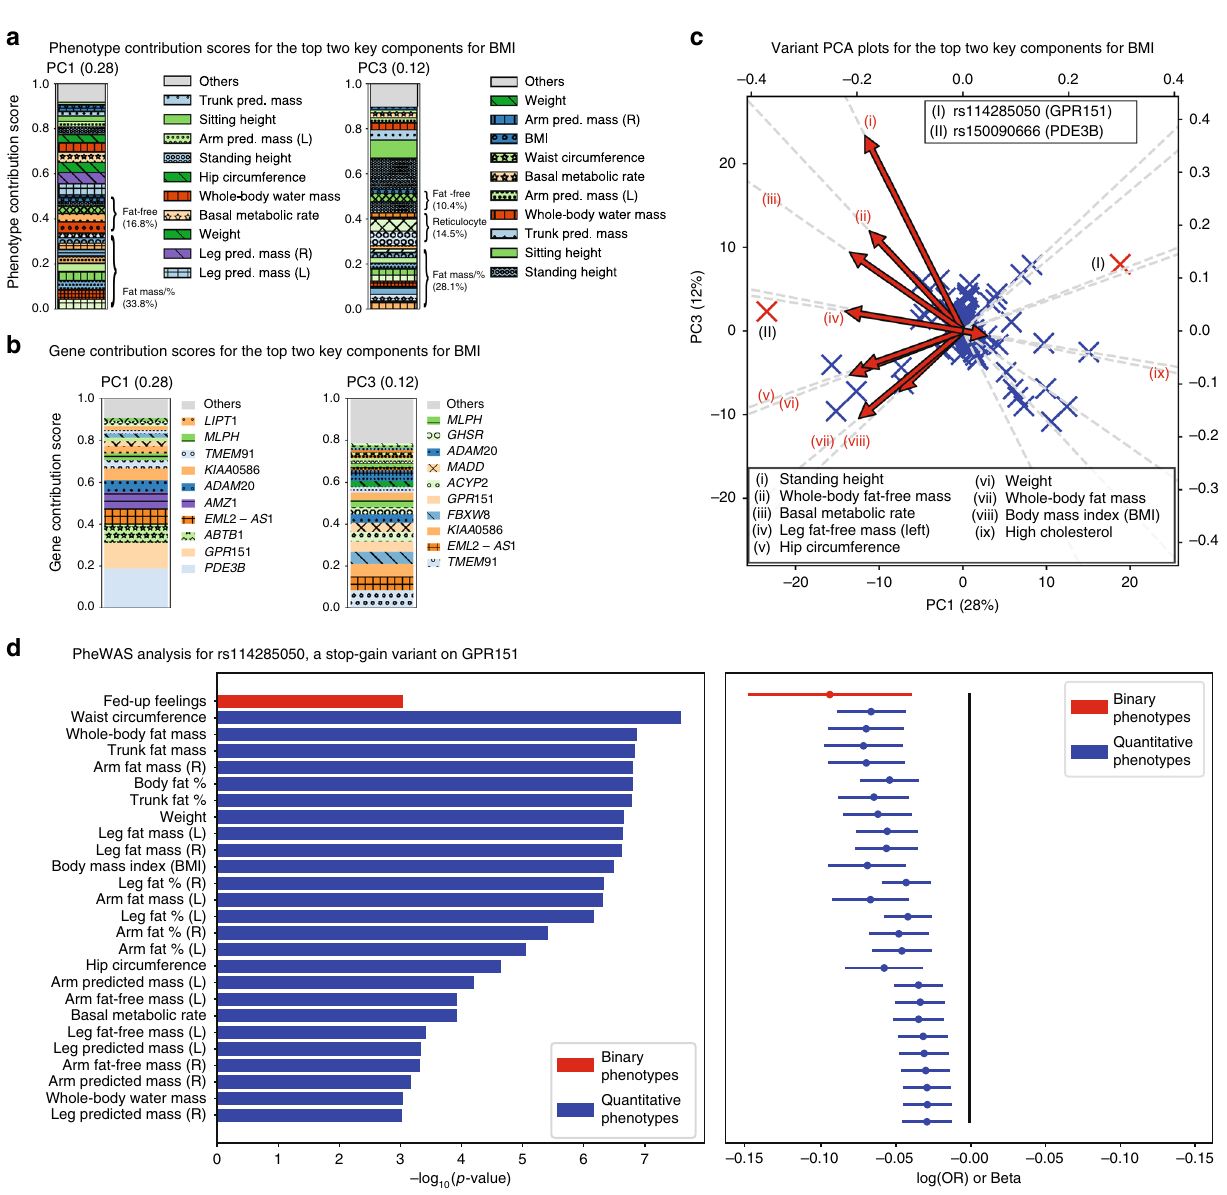
Fig. 4 DeGAs applied to the protein-truncating variants (PTVs) dataset. a , b Phenotype ( a ) and gene ( b ) contribution scores for the top key components associated with BMI based on phenotype grouping (Methods, Supplementary Table 2). c Variant PCA plot with biplot annotations for the top two components (Methods). The identi fi ed targets for functional follow-up (main text) are marked as (I) rs114285050 (a stop-gain variant on GPR151 ) and (II) rs150090666 ( PDE3B ). d Phenome-wide association analysis for GPR151 rs114285050. The p -values (left) and log odds ratio (OR) (binary phenotypes, shown as red) or beta (quantitative phenotypes, shown as blue) (right) along with 95% con fi dence interval are shown for the phenotypes with minimum case count of 1000 (binary phenotypes) or 1000 individuals with non-missing values (quantitative phenotypes) and strong association ( p < 0.001) and with this variants among all the phenotypes used in the study ( n = 337,199 White British individuals in the UK Biobank for binary traits and n > 331,000 for each quantitative trait, Supplementary Table 3). L: left, R: right, %: percentage, pred: predicted. Source data are provided in Supplementary Data 2 ( a , b ), Source Data fi le ( c ), and Supplementary Table 3 ( d